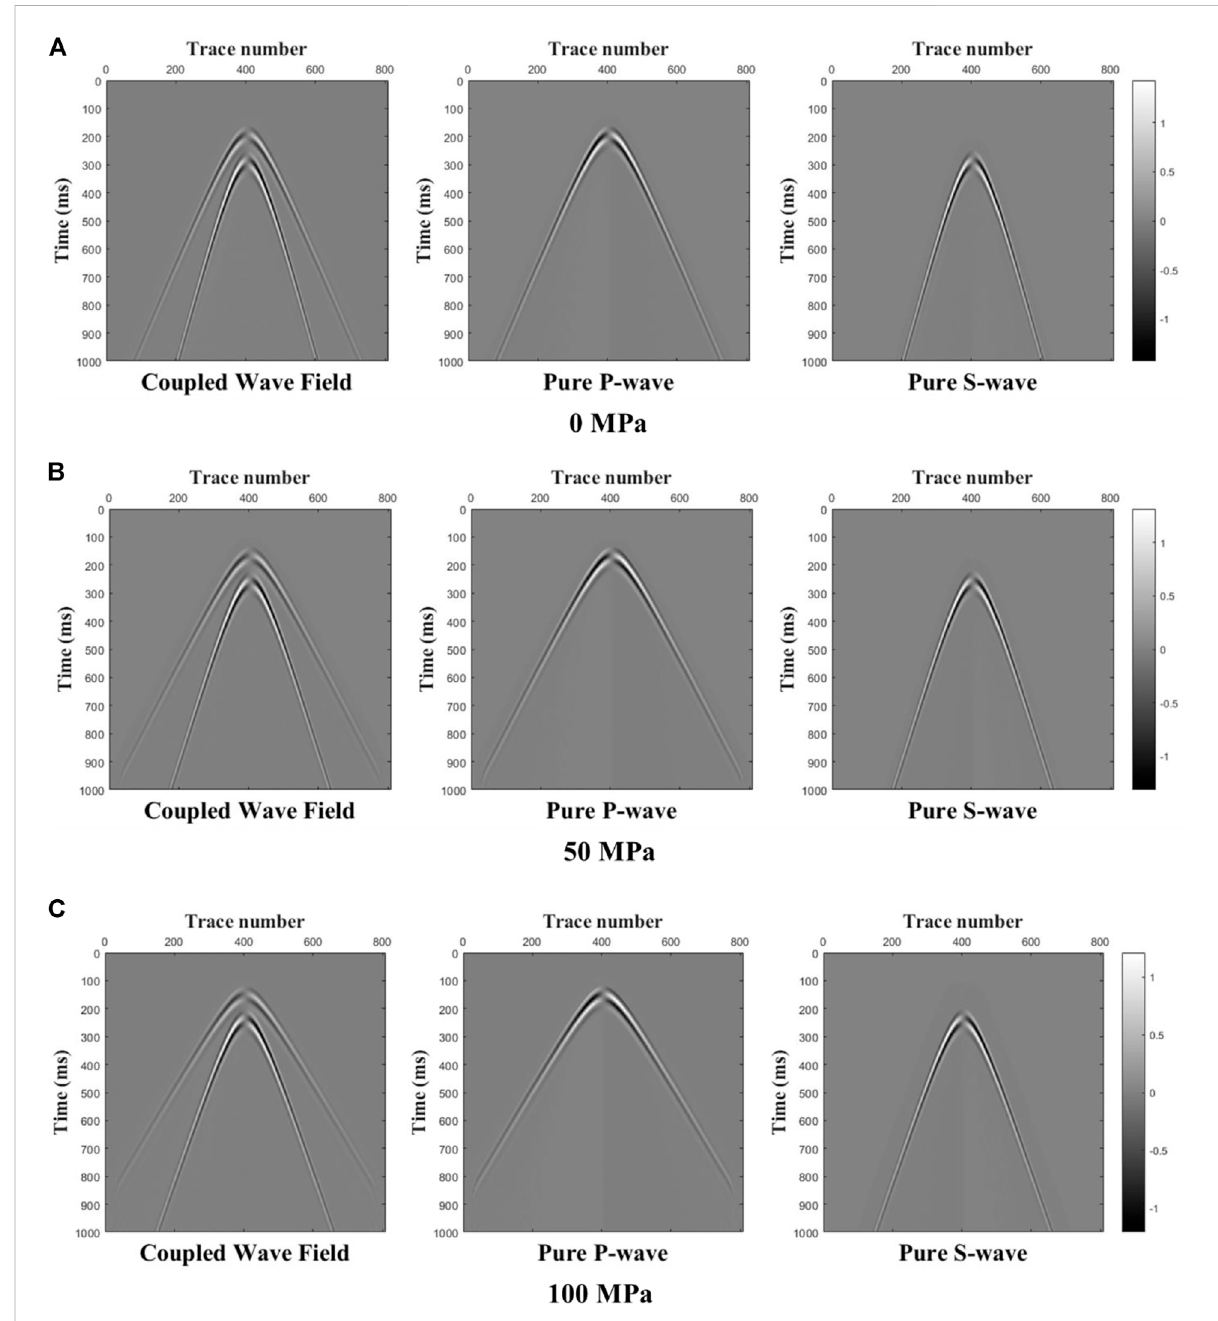
FIGURE 5 Coupled wave fi eldanddecoupled P-andS-wave fi eldrecordsofthe x -componentoftheparticle velocityforvariouscon fi ningstresses( (A) :0 MPa; (B) : 50 MPa; (C) : 100